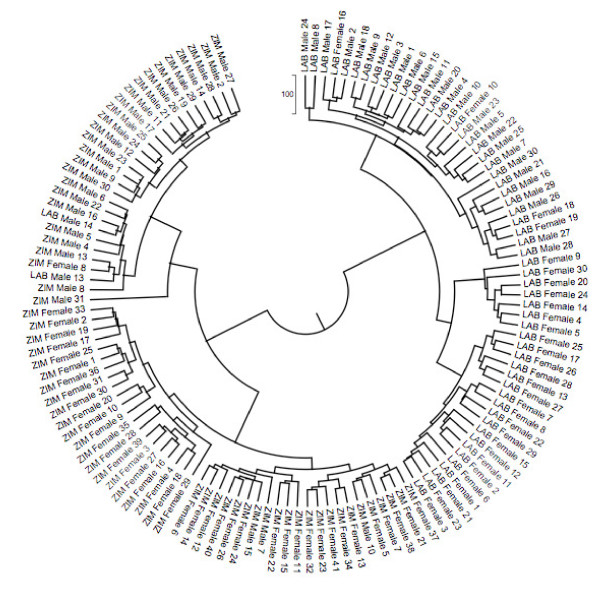
AFLP genotype hierarchical cluster analysis of male and female G. morsitans from laboratory and field populations. Using Ward's minimum variance method with pairwise Manhattan distances between individuals. AFLP bands from seven primer primers were used (Table 2), 597 AFLP bands from 129 individuals. Label prefixes LAB and ZIM denote laboratory and Zimbabwe samples respectively, followed by fly sex and sample number.